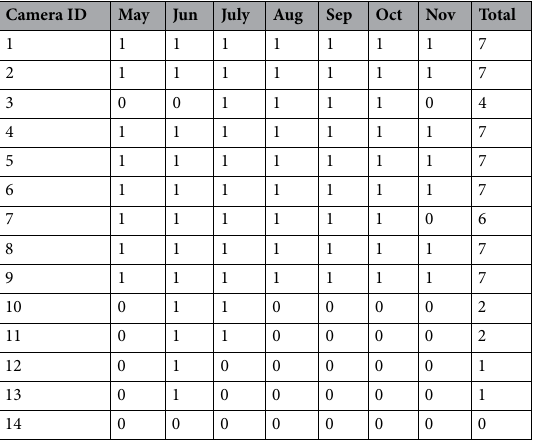
Table 1. Occurrence of captured sika deer in each camera trap over a period of 8